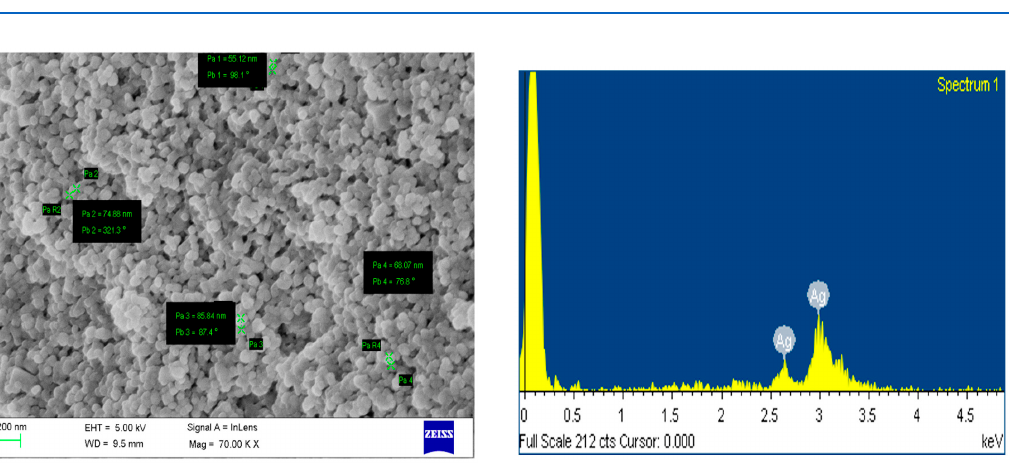
Fig. 4. Energy Dispersive X-Ray spectroscopy (EDX) of crude silver nanoparticles